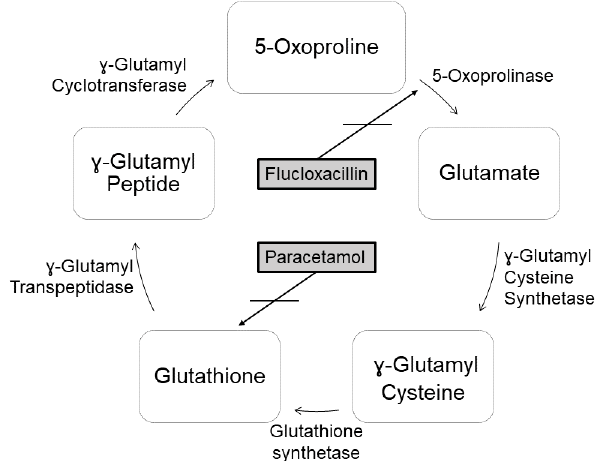
Figure 1. Glutamate–glutathione cycle (Emmett, 2014; Osborne et al., 2019; Weiler et al.,